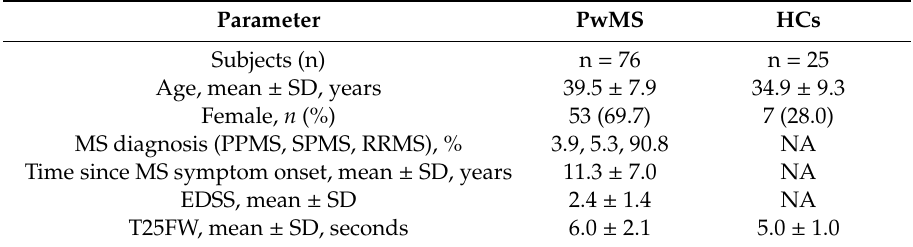
Table 2. Cohort demographics and characteristics for PwMS and HCs at baseline. Abbreviations: EDSS: Expanded Disability Status Scale, HC: Healthy control, MS: Multiple sclerosis, NA: Not applicable, PPMS: Primary progressive multiple sclerosis, PwMS: People with multiple sclerosis,